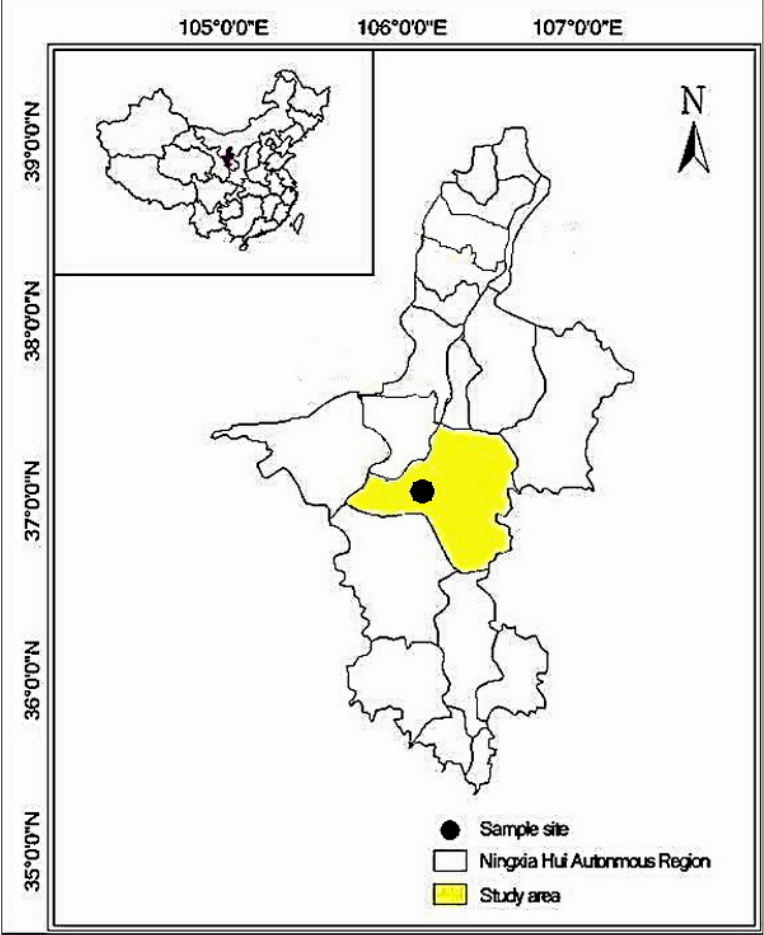
Figure 1. Study areas and sampling site in the Ningxia Hui Autonomous Region, northwestern China (TX, Wuzhong region).